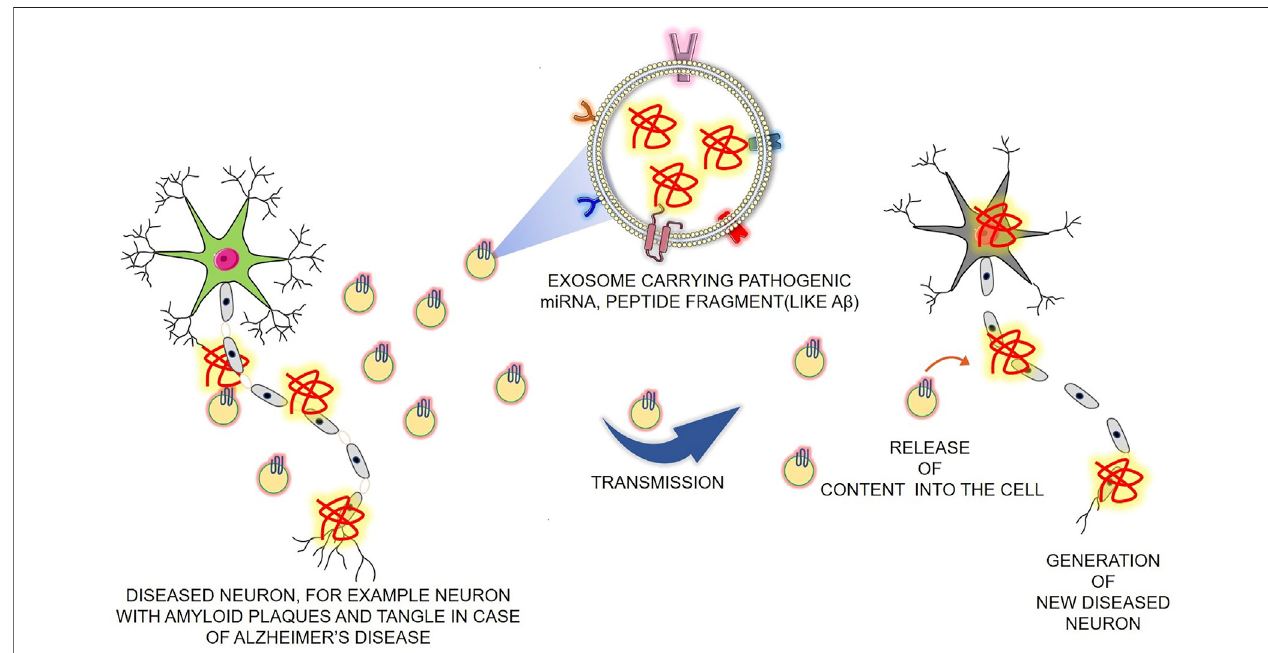
FIGURE 3 | Schematic representation of the role of exosomes as the pathogenic carrier in neurodegenerative disease. Pathogenic cargo-loaded exosomes are releasedfromthediseasedcell,andthecellsthattakeuptheexosomesgetasimilarkindofdisease.Thispicturerepresentsasimilarphenomenon,takinganexampleof how exosomes cancarry A β pathogenic peptides in their lumen and cause the propagation ofAlzheimer ’ s disease. (A β : amyloid-beta) (Some component ofthe fi gure is adapted from Servier Medical Art; Servier is licensed under a creative commons attribution 3.0 unported license (https://smart.servier.com/).